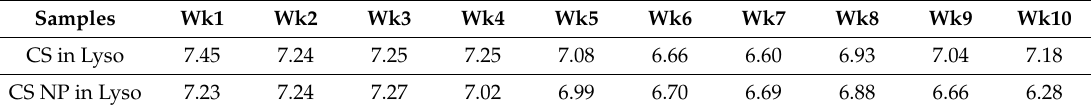
Table 1. Measured pH of the lysozyme solution containing different samples at different time